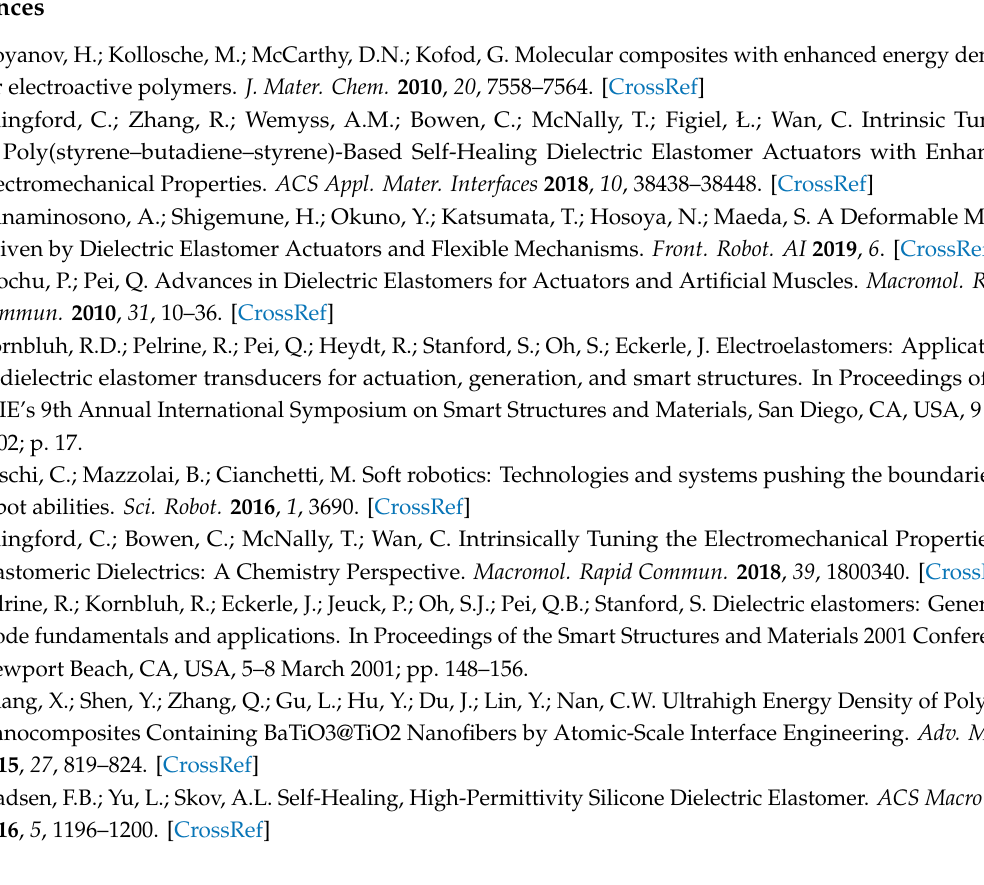
Figure S1: GPC trace from the synthesis of TANI, Figure S2: 1 H NMR with assigned peaks of TANI, Figure S3: FTIR of TANI, SBS and TANI-SBS with notable peaks highlighted, Figure S4: FTIR of TANI, PB and TANI-PB with notable peaks highlighted, Figure S5: 1 H NMR of PB, e-PB and TANI-PB with notable peaks assigned, Figure S6: DMTA of 50 mol% TANI-PB with T g transition peaks highlighted, Figure S7: UV-Vis spectroscopy of TANI, Figure S8: GPC trace of SBS and PB, Figure S9: Stress strain curve of SBS and PB, Figure S10: (a) relative permittivity, (b) tan δ , (c) AC Conductivity and (d) phase angle for TANI in the emeraldine salt oxidation state, Figure S11: AC Conductivity of (a) SBS, 25 mol% TANI-SBS and 35 mol% TANI-SBS and (b) PB, 1 mol% TANI-PB, 25 mol% TANI-PB and 35 mol%